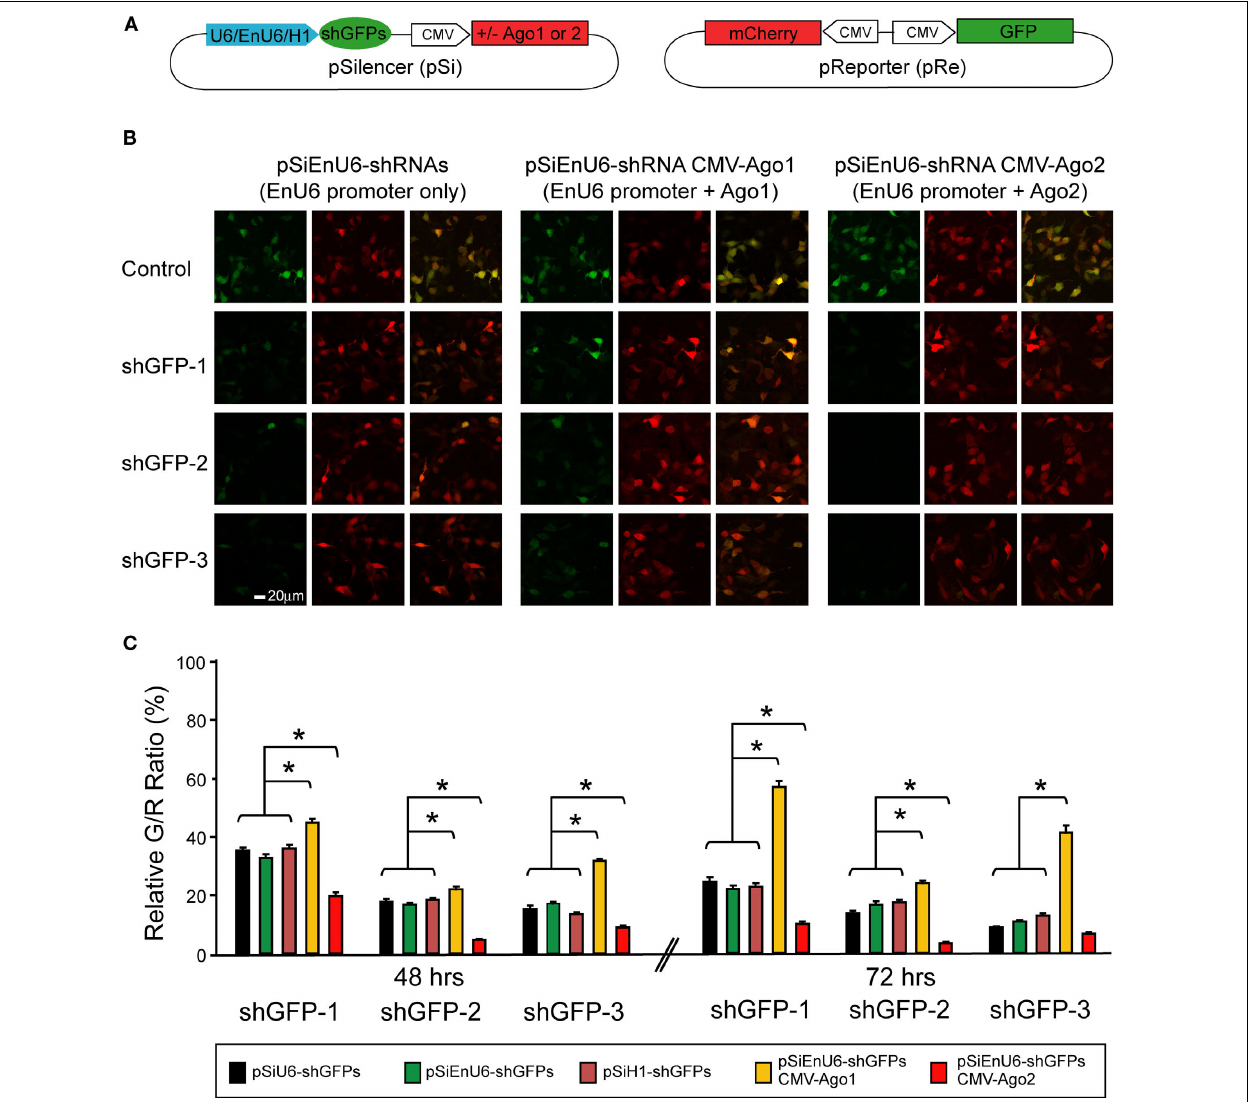
FIGURE 2 | Effect of different promoters and Ago2 co-expression in RNAi effi cacy. HEK293 cells, transfected with pSi and pRe constructs were imaged after 48 or 72 h to evaluate GFP knockdown effi ciency by the green to red (G/R) fl uorescence intensity ratio. (A) Diagram of the pSi constructs (left) containing U6, enhancer added U6 (EnU6) or H1 promoter driven shGFPs, and the pRe construct (right) for simultaneous GFP and mCherry expression. (B) Representative images from cells 2 days after transfection of pSi constructs containing EnU6 driven shGFPs with or without Ago protein co-expression.